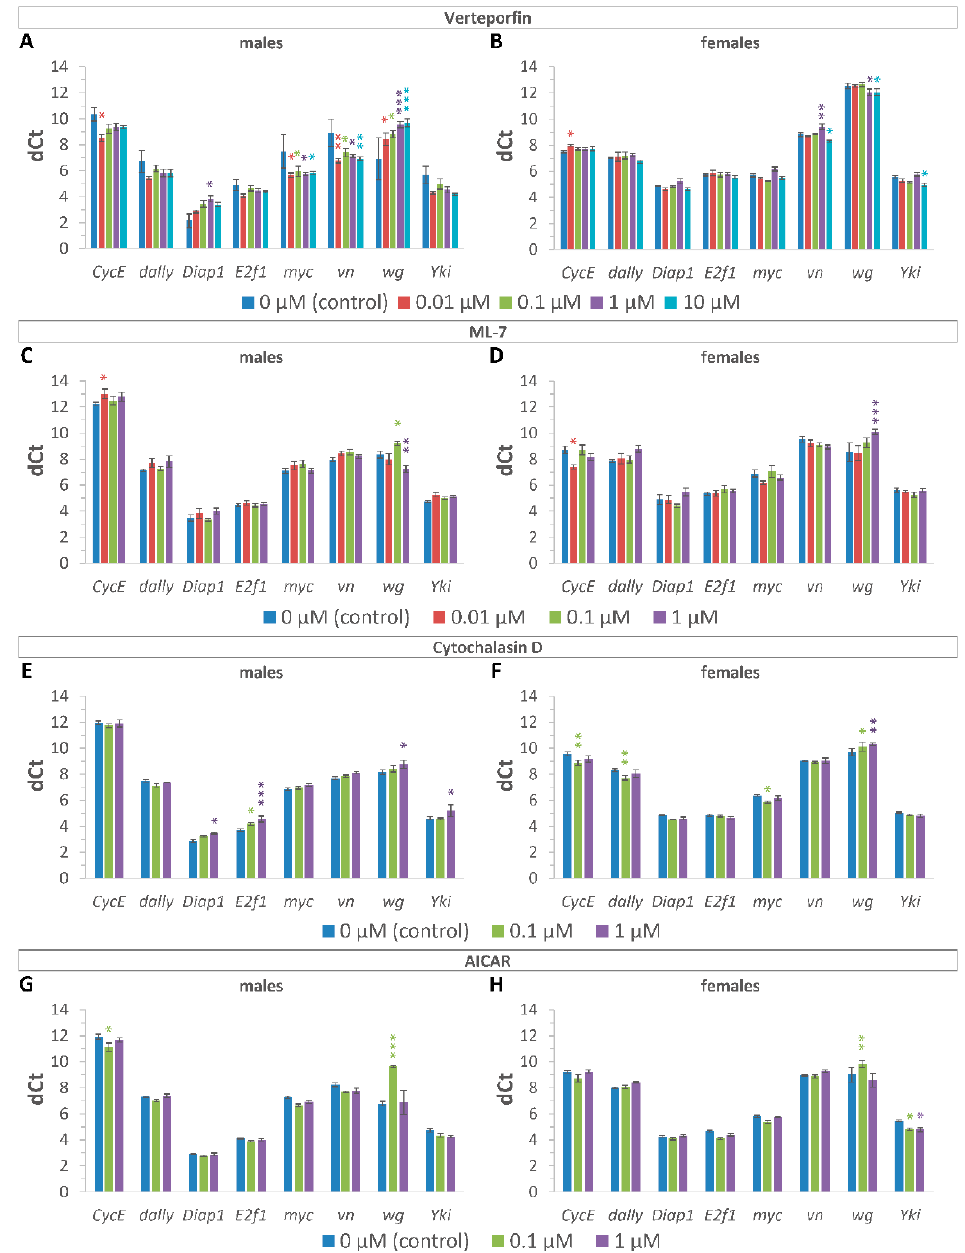
Figure 2. Effects of YAP/TAZ inhibitors on the expression level of Yki target genes. Estimation of the expression level in 10 day-old males and females after treatment with VP ( A , B ); ML7 ( C , D ); CD ( E , F ); AI ( G , H ). Two-way ANOVA (age × gene) followed by post hoc Duncan test was used to compare differences in expression levels of genes between 10-day-old and 20-day-old flies, * p < 0.05, ** p < 0.01, *** p < 0.001. The Ct (cycle thresholds) values are inversely proportional to the mRNA transcript levels. The delta Ct (dCt) values were calculated as the differences in Ct values for target genes and reference genes ( β -Tubulin and RpL32 ). Higher dCt values represent a lower expression level. The error bars show standard errors. The experiments were performed in three biological replicates and three technical replicates ( n = 3, repeated three times). The samples included 20 males and 10 females.